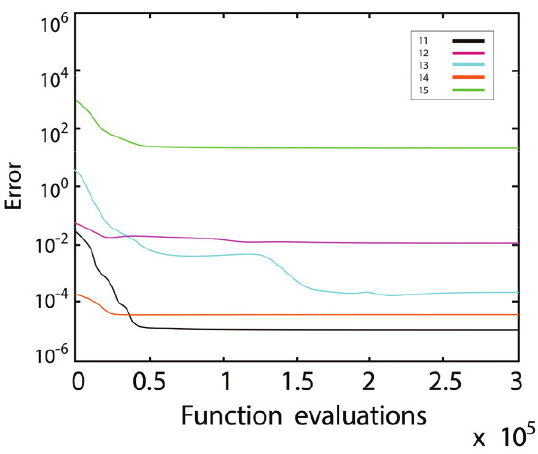
Figure 14. The results of applying the MSCA on F 21 – F 25 (Conver- gence of Functions F 21 – F 25